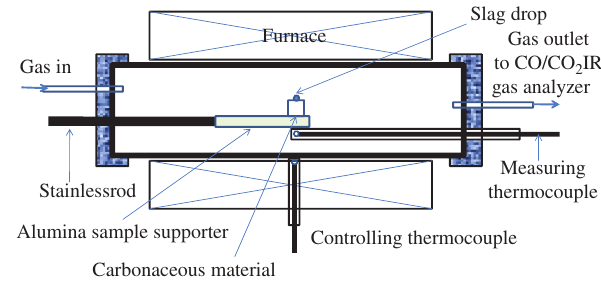
Figure 1: Schematic diagram of experimental setup